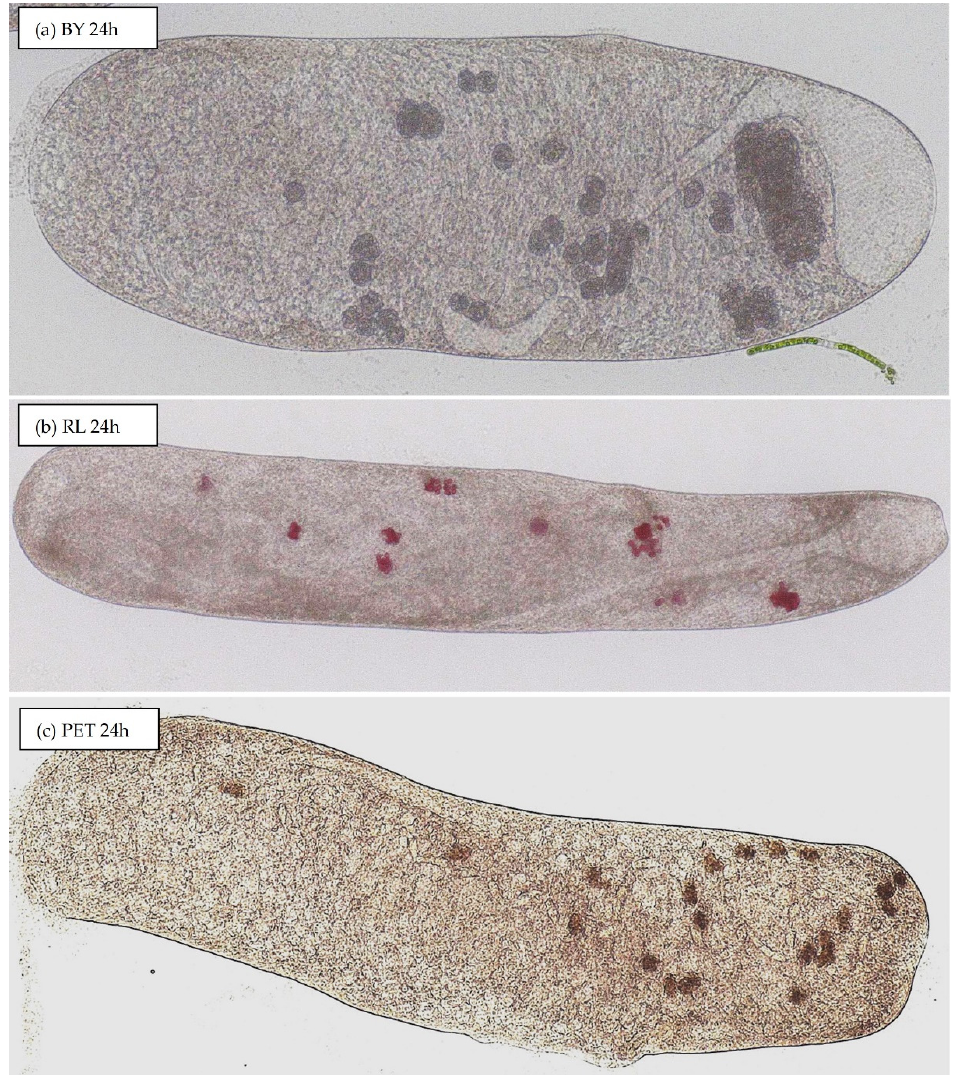
Figure 3. Food vacuoles formed in S. ambiguum in ( a ) BY, ( b ) RL, and ( c ) PET suspensions after 24 h.